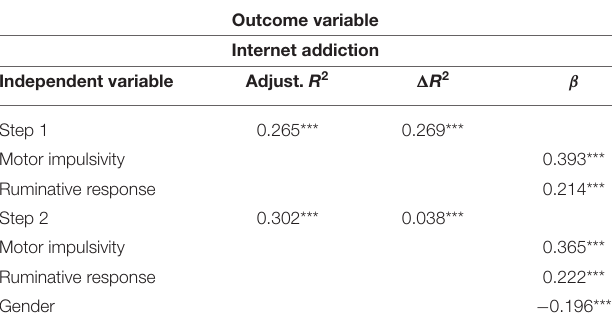
TABLE 7 | Results of hierarchical linear regression analyses inserting motor